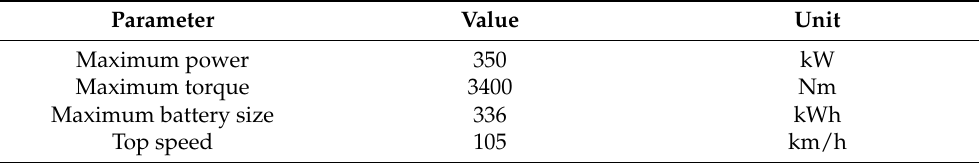
Table 1. Lion8 All-Electric refuse truck